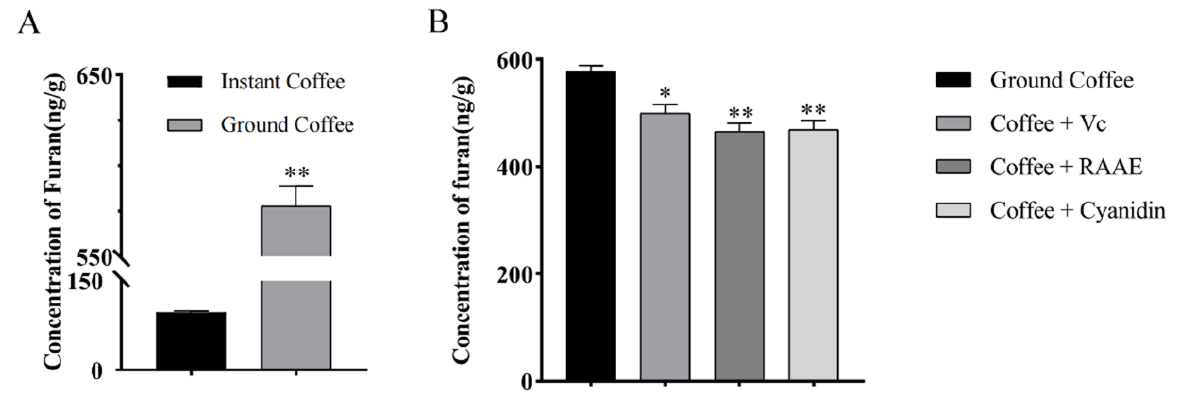
Figure 2. ( A ) Furan content in commercially available instant coffee and ground coffee and ( B ) the reduction effect of different antioxidants on the furan content in coffee. * means p < 0.05, and ** means p < 0.01. In order to distinguish the reduction rate of furan content in different red-fleshed apple varieties, 10 different types of RAAEs were added to the same coffee solution.